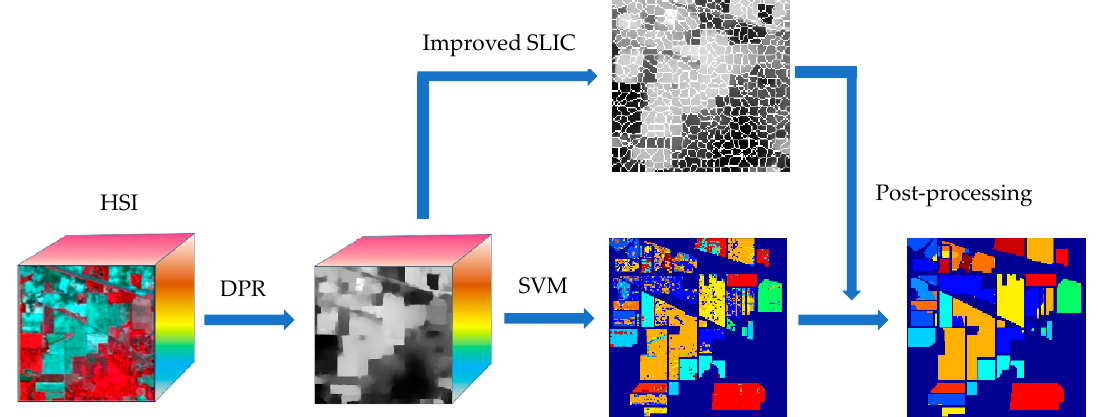
Figure 2. The framework of the proposed classification scheme.